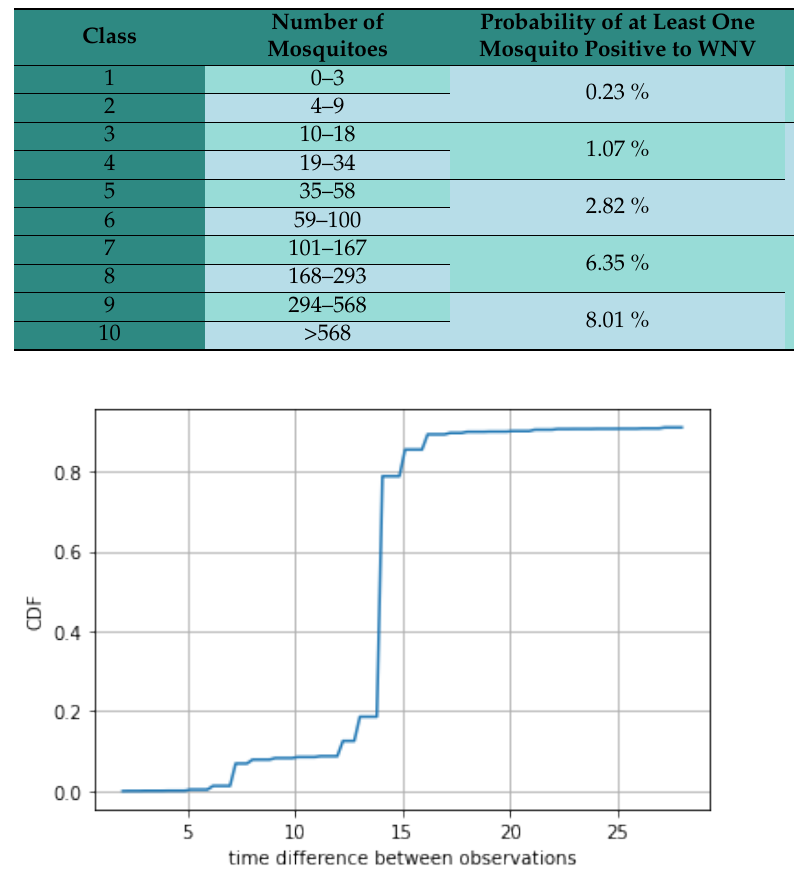
Figure 3. CDF of time difference in days between 2 consecutive observations for the case of Culex Italy. Furthermore, the auto-calibration process was tuned to max_depth = 5, number of estimators = 23, and and it was decided that the optimal number of features is 16. The selected features with their corresponding importance are presented in Figure 4.